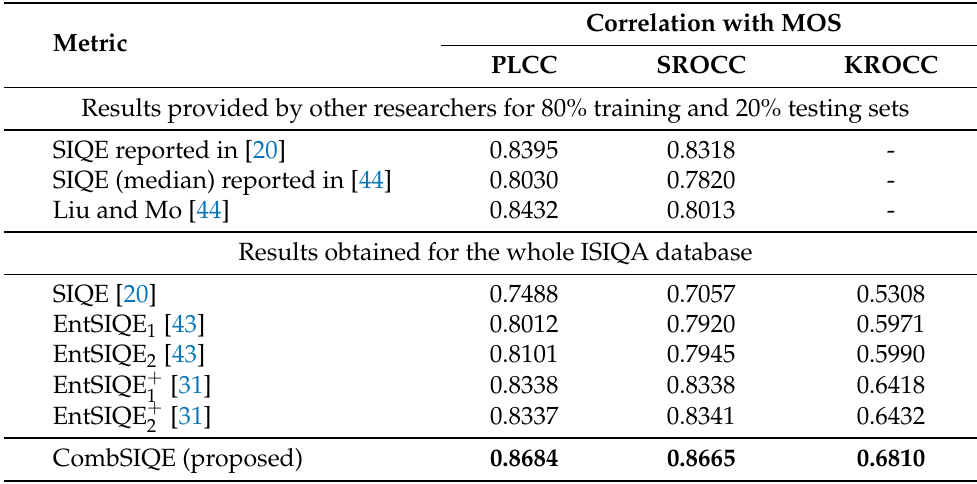
Figure 3. Illustration of the experimental procedure used in the paper. Table 1. Correlations with subjective scores obtained for the ISIQA database using the proposed combined metric and previously proposed methods. The best results are presented in